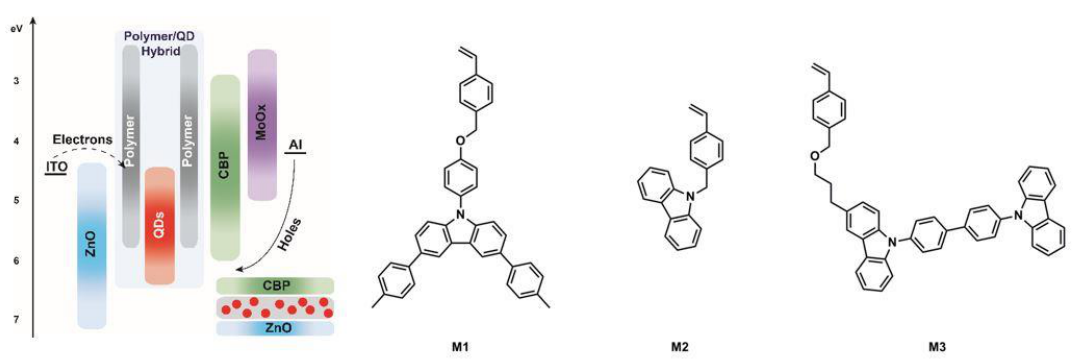
Figure 12. Scheme of the band gap alignment in an QLED with inverted device architecture (left) as well as 3 new monomers for the preparation of a semiconducting blockcopolymer; see [138] for more details.